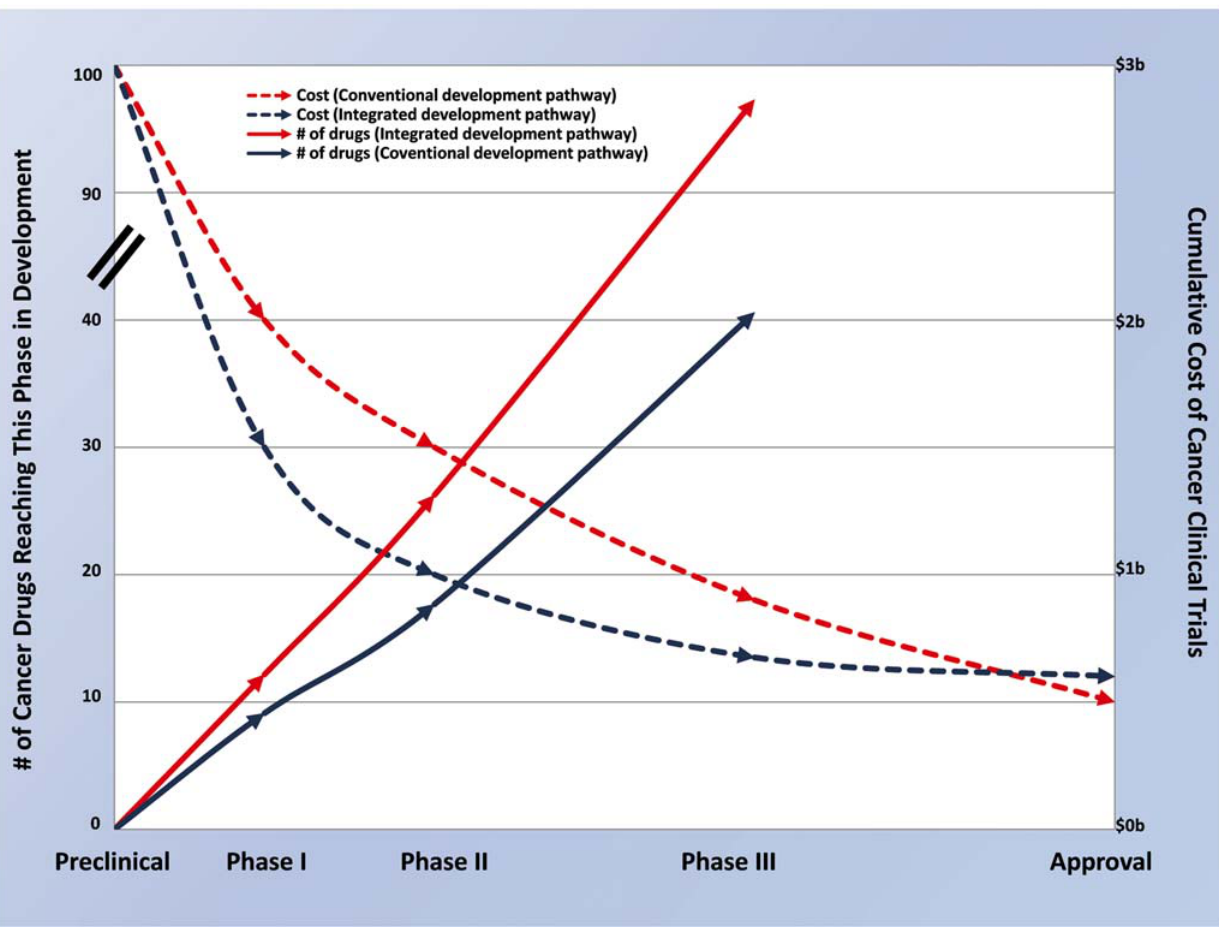
Figure 1. An idealized view of the opportunity provided by a comparative and integrated oncology drug development path. This is a theoretical illustration of 100 preclinical agents that may be evaluated by either a conventional or an integrated and comparative drug development path. Data for transition rates and costs of Phase I, II, and III trials are based on published cost estimates [3] and reported clinical phase transition probabilities for investigational oncology compounds from the 20 largest firms (by pharmaceutical sales in 2005) from 1993 to 2002 [2,4]. Estimates used to derive a vision of the benefit of an integrated approach to drug development are based, in part, on estimates of transition and approval rates for non-oncology therapeutic areas where informative preclinical models exist [5]. Relative to the conventional development path, the integrated development path is characterized by improved success early in clinical development and a reduction in drug failures late in clinical development. Conventional oncology drug development results in approximately 40% of eligible agents transitioning from preclinical to Phase I, 75% from Phase I to II, 60% from Phase II to III, and 55% from Phase III to approval [2]. Therefore, for every 100 preclinical candidates, only ten new drugs will reach the clinic. Of most significance are failures that occur late in the development path (i.e., after Phase II or Phase III evaluation). With